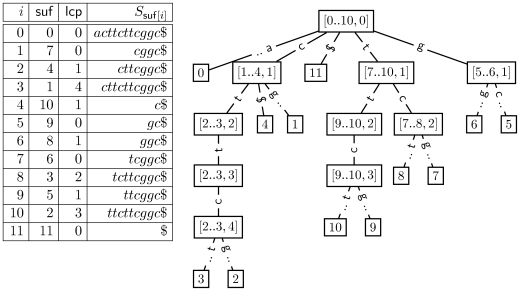
The enhanced suffix array yields a tree structure of nested suffix intervals.The enhanced suffix array for the sequence S: = attcttcggc (left) and its suffix interval tree (right), equivalent to the suffix trie in Fig. 2, is shown. The array suf represents the lexicographical order of the suffixes in S$. In other words, S
suf[0], S
suf[1], …, S
suf[n] is the sequence of suffixes of S$ in ascending lexicographic order. The lcp-table lcp is an array of integers such that for each h, 1≤h≤n, lcp[h] is the length of the longest common prefix of S
suf[h−1] and S
suf[h]. A suffix interval [l‥r, h] denotes an interval in the suffix array with lcp[i]≥h for all i, l+1≤i≤r, i.e. all suffixes in the interval [l+1‥r] have a longest common prefix of length at least h. Additionally, requiring l = 0 or lcp[l]<h makes the suffix interval left maximal and requiring r = n or lcp[r+1]<h makes it right maximal. The suffix interval [0‥10, 0] spans the whole suffix array and is equivalent to the root of a suffix interval tree. This interval contains five subintervals, one for each character in S$, with h = 1. Equivalently, the root node of the suffix interval tree has five children. Note, that two children, labeled by 0 and 11, are singletons. The child nodes of singletons are not explicitly shown here.